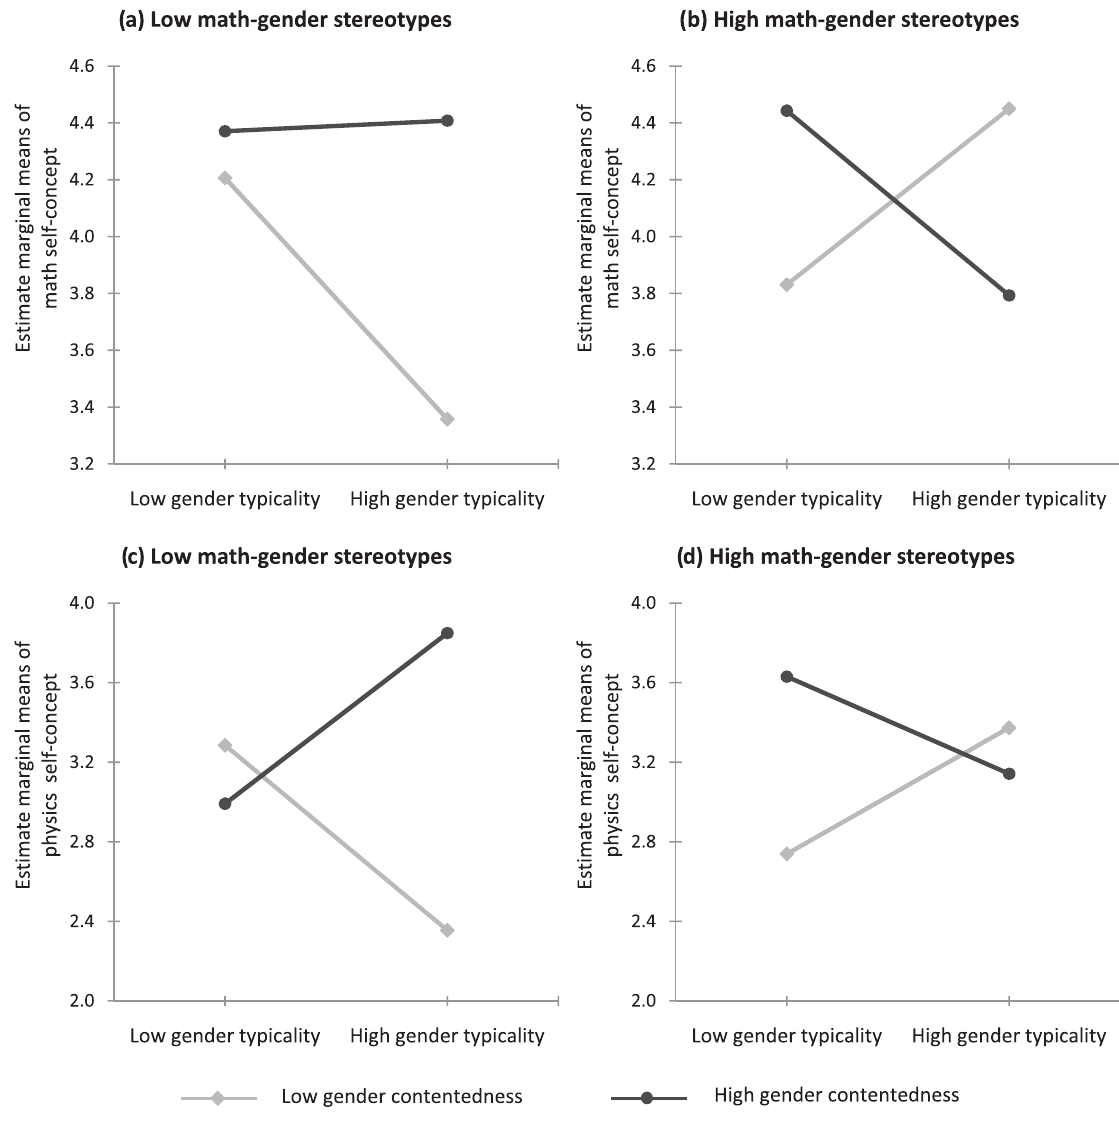
FIG. 2. Three-way interactions between felt gender typicality, gender contentedness, and math-gender stereotypes on math self- concept (a,b) and on physics self-concept (c,d) for females (age and GPA scores in math and physics are control variables).